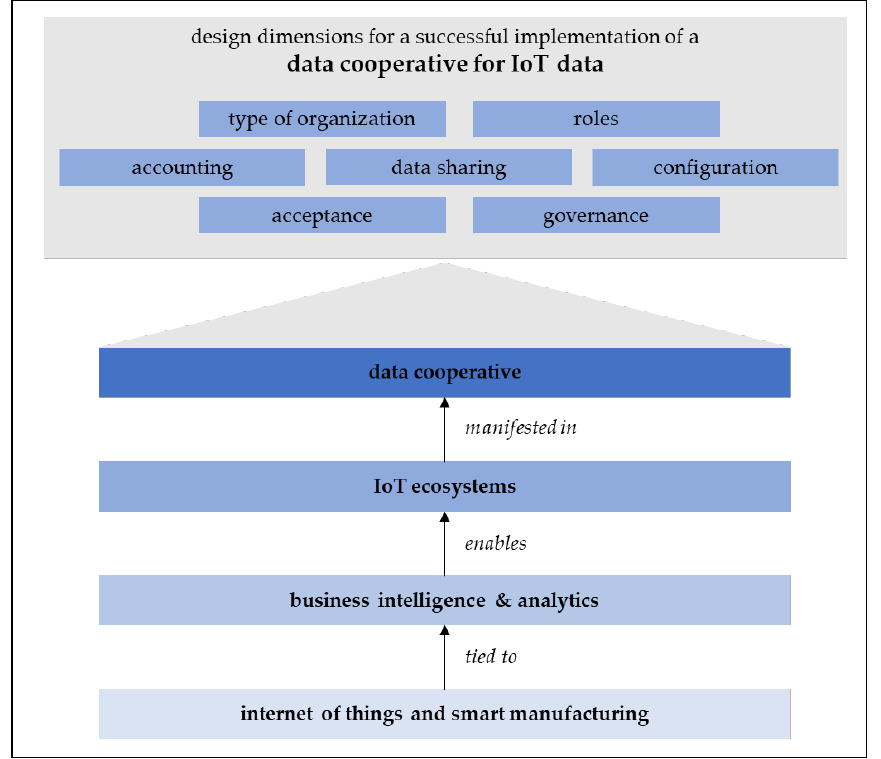
Figure 4. Conceptual framework.